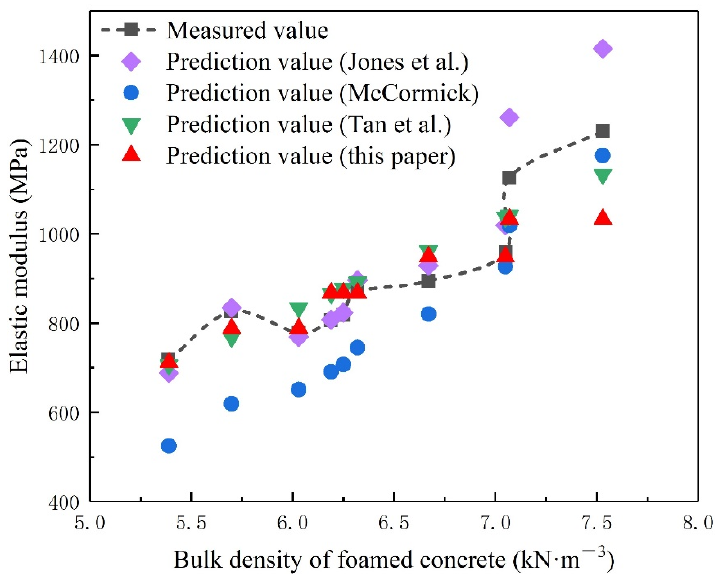
Figure 13. Comprehensive comparison of calculation results of elastic modulus of foamed concrete (Jones et al. [22], McCormick [31] and Tan et al. [41]).